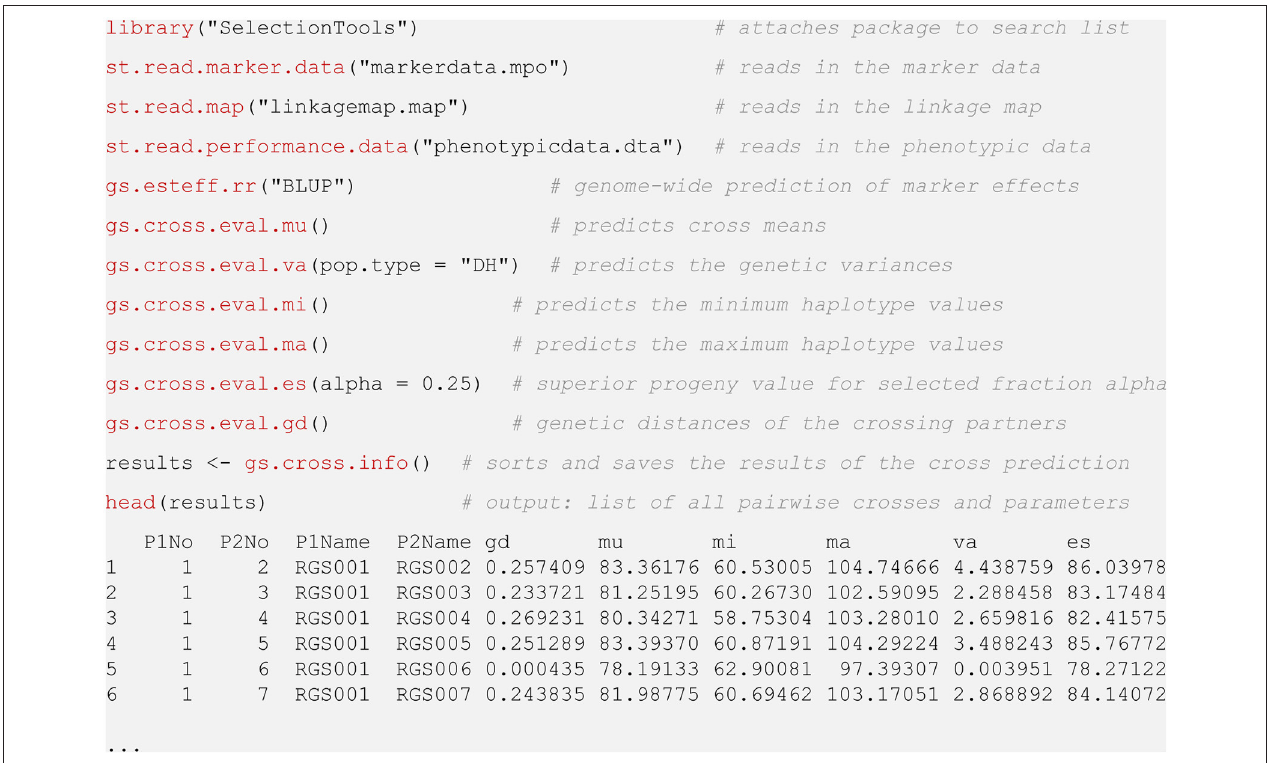
FIGURE 5 | Demonstration of R Code used for cross prediction with package